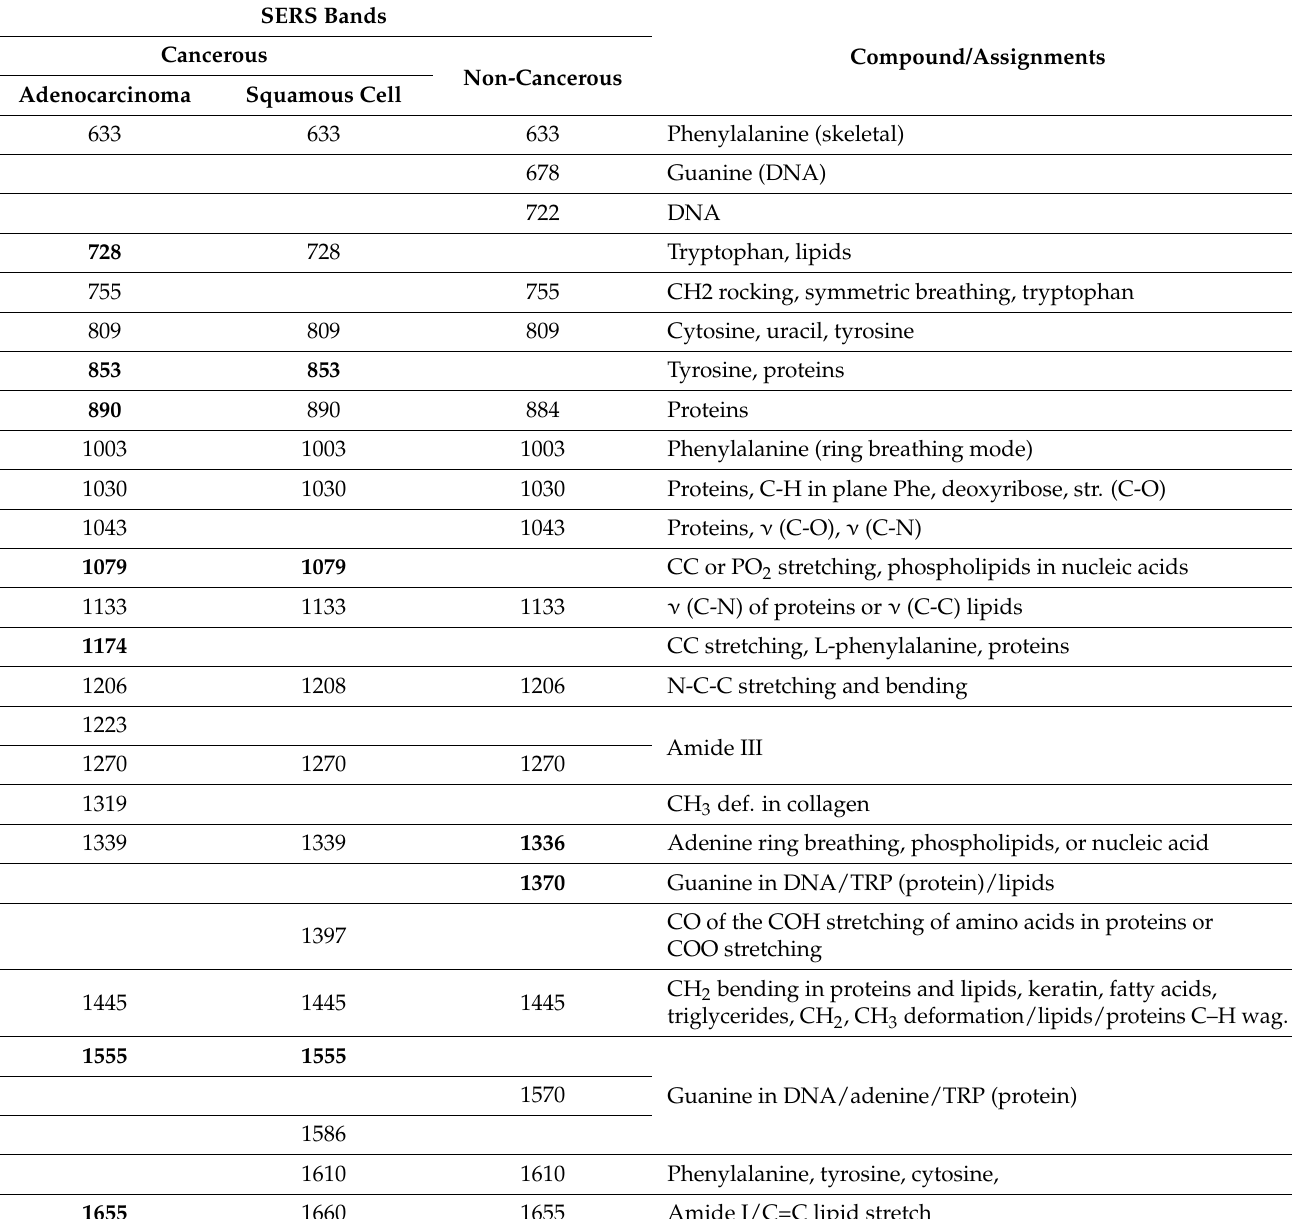
Table 1. Tentative assignments of bands observed in SERS spectra of adenocarcinoma and squamous cell [12,59,61–68]. The bands that show significant differences in intensity are